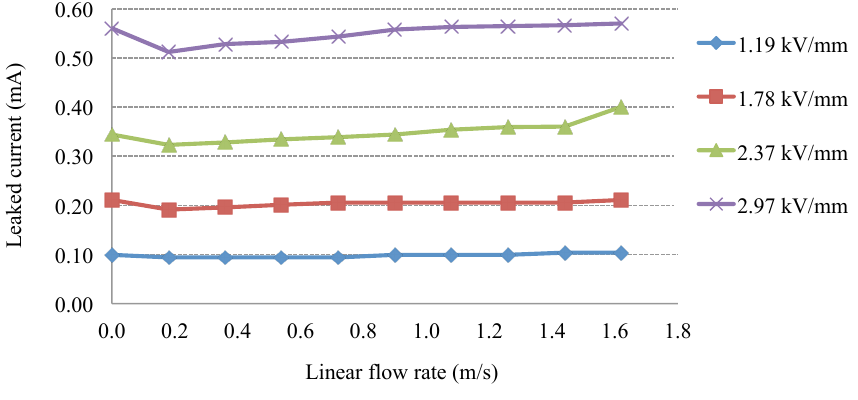
Figure 13. The measured leaked current in the ERF valve at various flow velocities and applied E-fields is